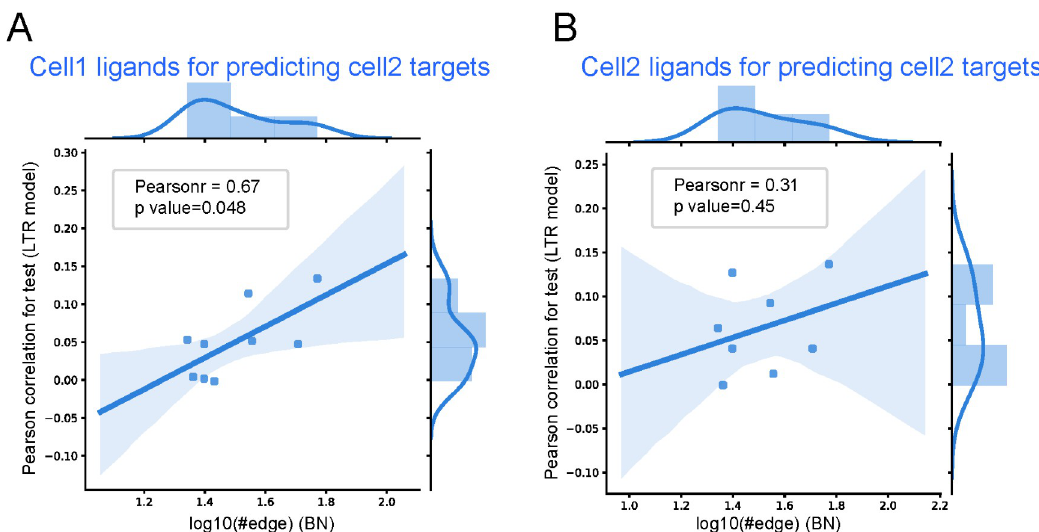
Fig 5. LTR comparison for the aging data. Comparison between the ability of the LTR model to predict target expression change when learning the model using cell pairs identified by the BN (A) and the same cell type (B).